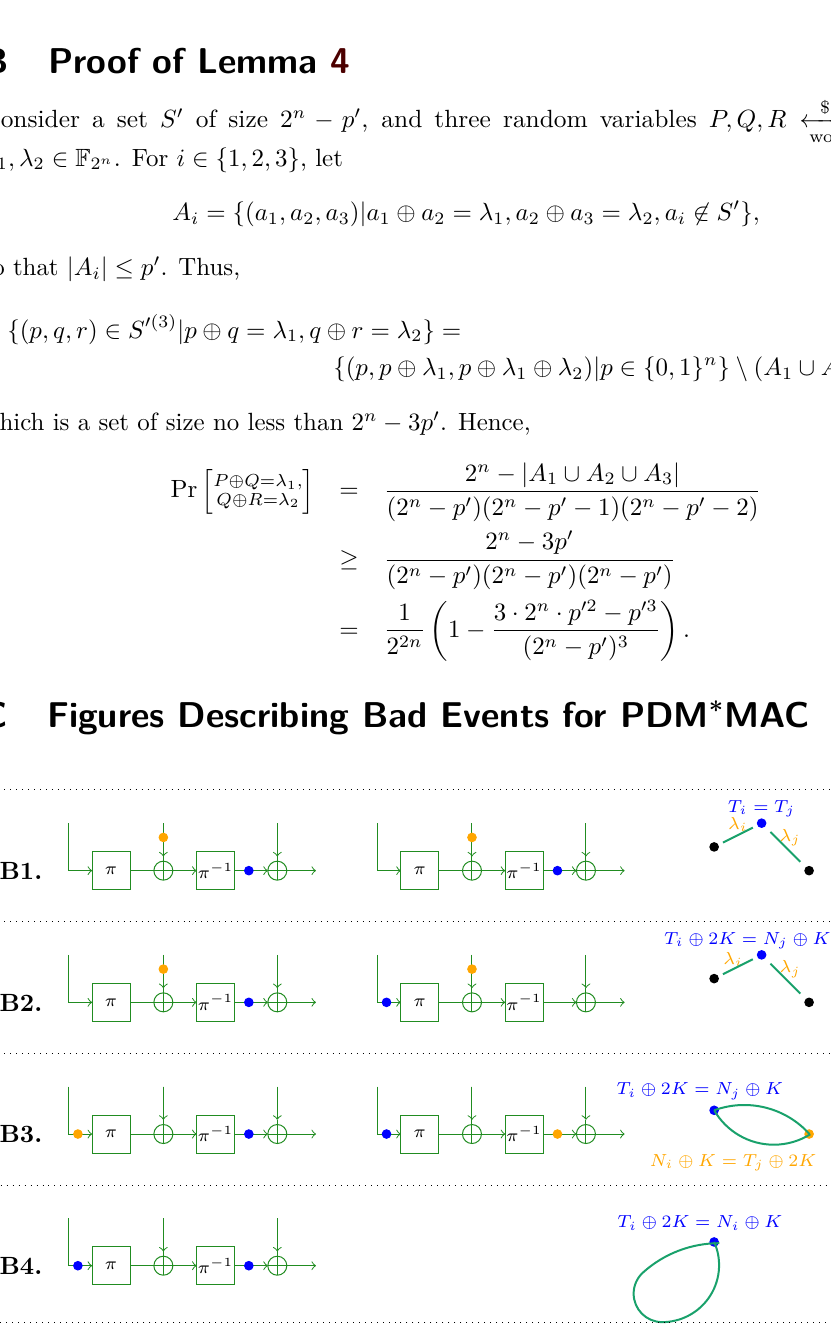
Figure 8: Collisions amongst one or two authentication queries - Figurative and graphical representations of the bad